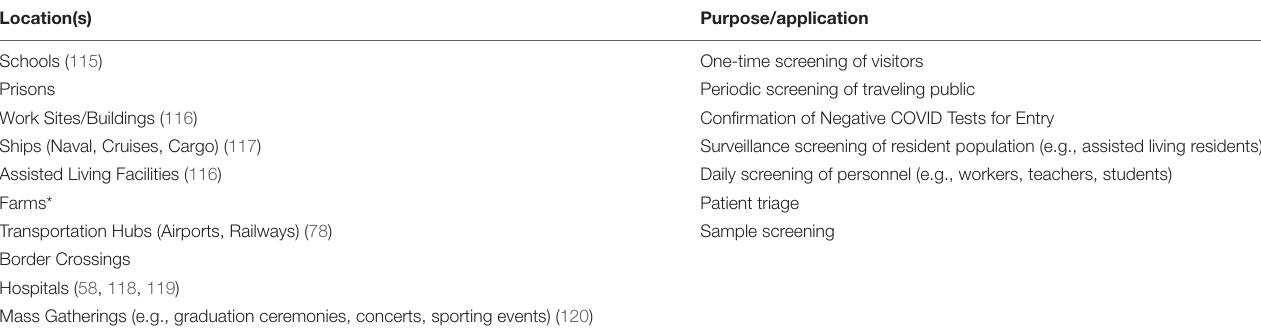
TABLE 3 | Locations where biomedical detection dogs have or could be deployed during a disease